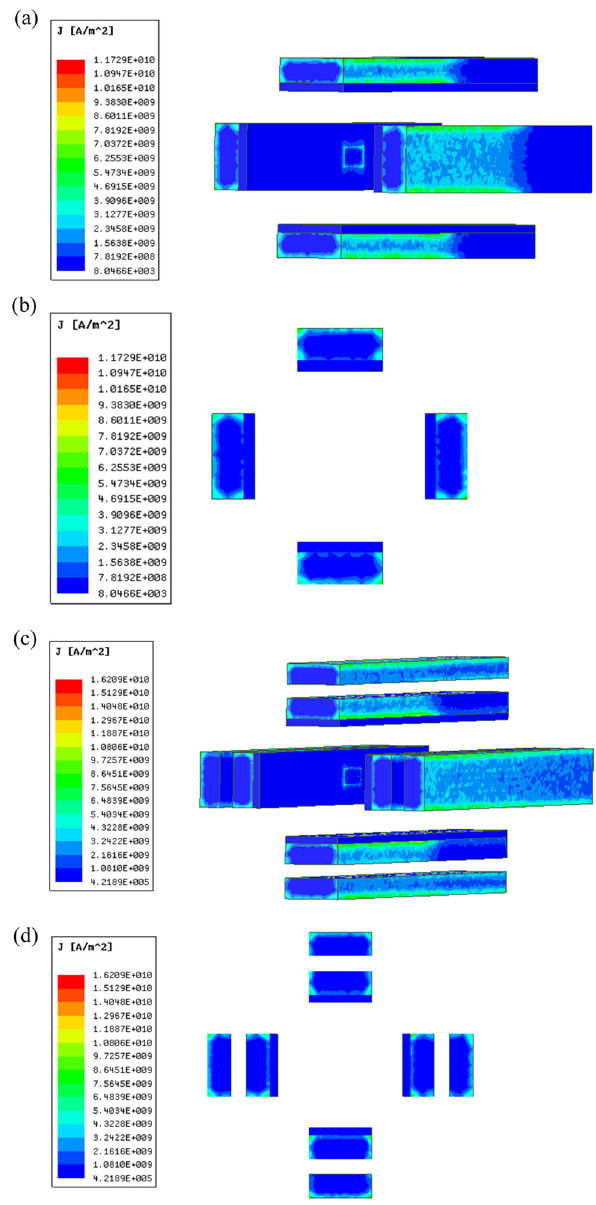
Figure 6: Current distribution in the rail. ( a ) Current density of CFREL, ( b ) current in cross - section of CFREL, ( c ) current density of ECFREL, and ( d ) current in cross - section of